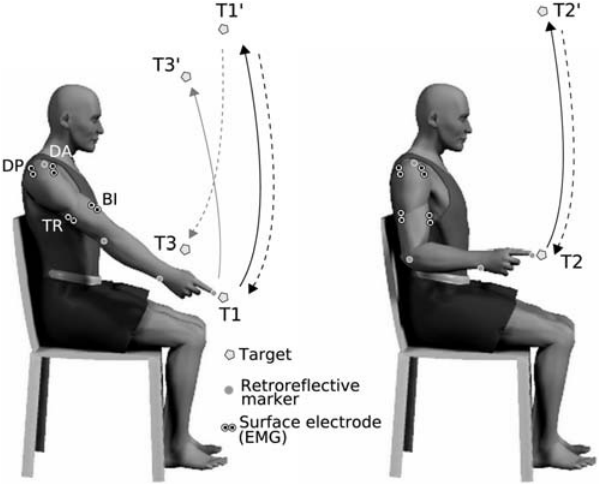
Figure 3. Illustration of the experimental setup. ( Left ) Black trajectories show the 1-dof pointing task between targets T1 and T1 9 . Gray trajectories show the 3-dof experiment, starting from fully- extended arm postures (targets T1-T3 9 and T1 9 -T3). ( Right ) Vertical 2- dof pointing movements, between targets T2-T2 9 . The position of the surface electrodes (for EMGs) and the kinematic markers is shown. Abbreviations: DA, Deltoid (Anterior); DP, Deltoid (Posterior); BI, Biceps and TR, Triceps. doi:10.1371/journal.pcbi.1000194.g003 1-dof case inherently led to lower TPV values of upward compared to downward movements. Interestingly, the difference between U and D movements in the gravity field was caused by the zero-torque period, during which the arm is approximately in free fall.